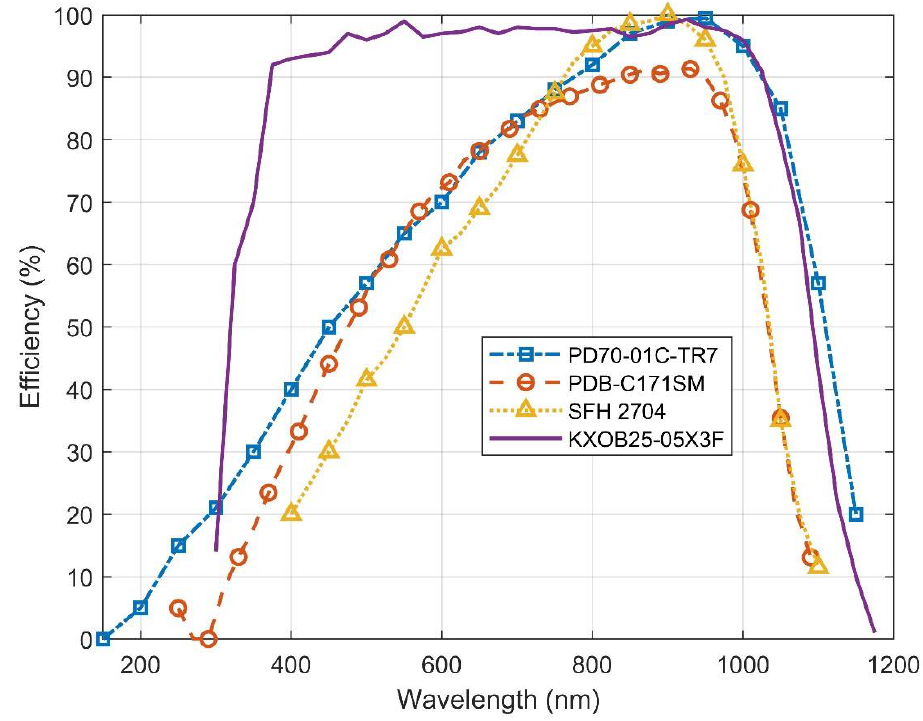
Figure 4. Quantum efficiency of the PD70-01C-TR7, PDB-C171SM and SFH 2704 photodiodes, as well as the KXOB25-05X3F solar cell.